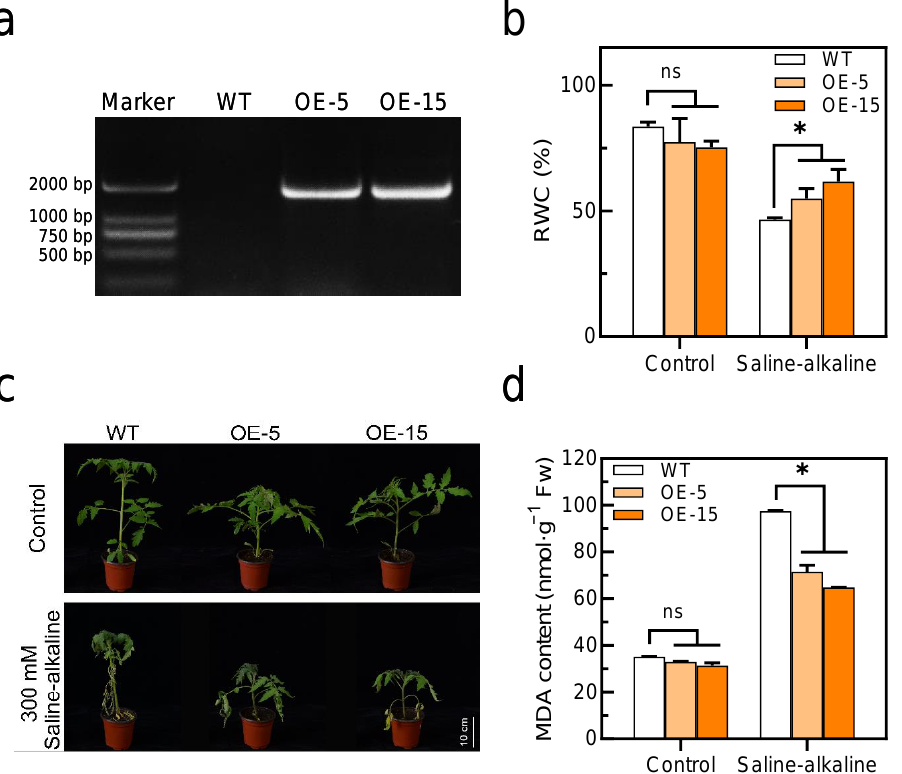
Figure 4. Overexpression of SlAREB1 confers enhanced saline–alkaline tolerance in transgenic tomatoes. ( a ) Confirmation of the presence of the transgene in SlAREB1-overexpression lines by PCR analysis. ( b ) The relative water content of wild-type (WT) and transgenic (OE-5 and OE-15) tomato leaves with 300 mM saline–alkaline mixed solution for 7 d. ( c ) Phenotype of tomato seedlings under 300 mM saline–alkaline stress in WT and transgenic tomatoes. ( d ) The MDA content of WT and transgenic tomatoes with 300 mM saline–alkaline mixed solution for 7 d. Distilled water was used as control. Values represent averages of four independent measurements, and error bars represent standard errors. Asterisks denote a significant difference compared with the control (* p <